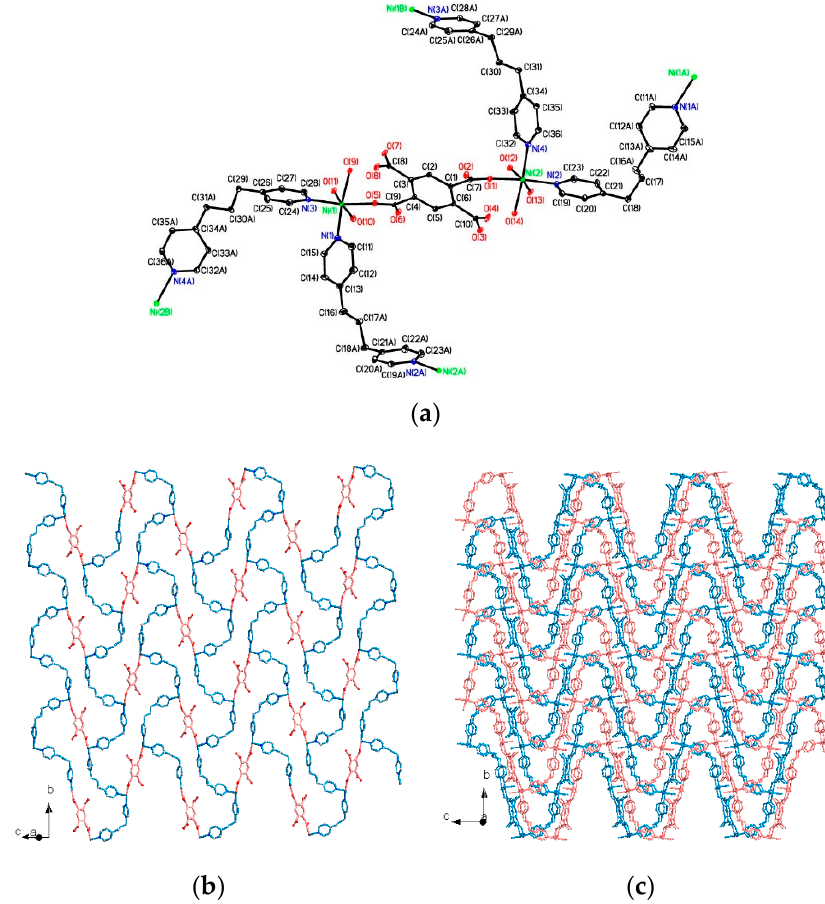
Figure 1. ( a ) Coordination environments of two Ni(II) ions with atom labeling scheme (ORTEP drawing, 30% thermal ellipsoids). The solvents, ethanol and water molecules and H atoms are omitted for clarity. ( b ) A 2D layered metal-organic framework (MOF) constructed by bpp (blue) and BT 4 − (red) bridges. Coordinated water molecules and guest ethanol and water molecules are omitted for clarity. ( c ) The 3D supramolecular architecture. The solvents, ethanol and water molecules and H atoms are omitted for clarity.